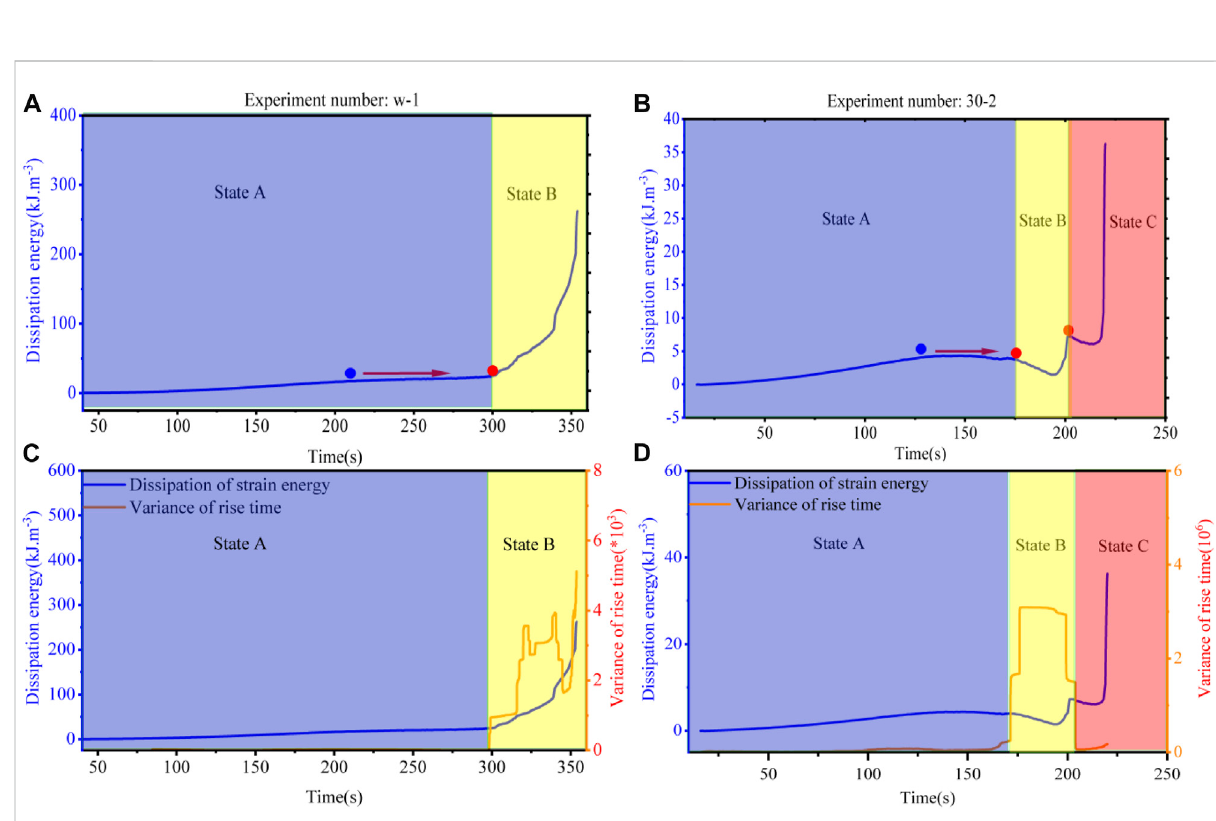
FIGURE 12 Mechanism of the CSD phenomenon in sandstone. (A,C) fi rst typical kinetic system of sandstone and (B,D) second typical kinetic system of